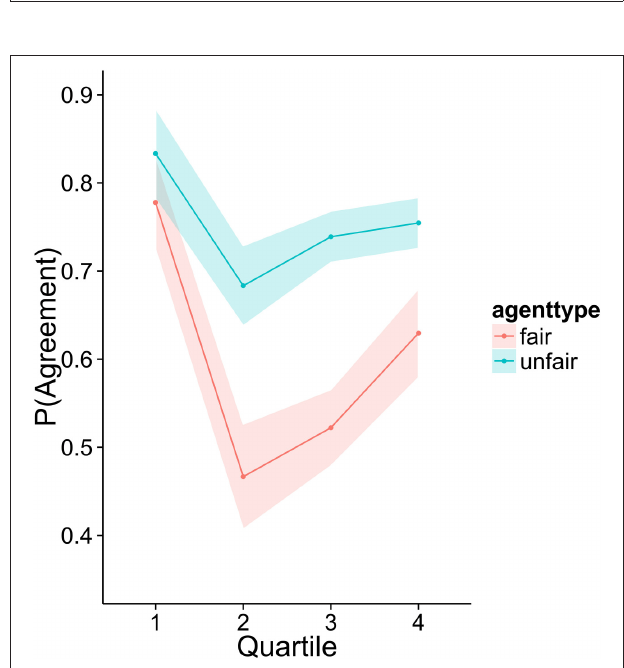
FIGURE 6 | Proportion of trials in which an agreement was